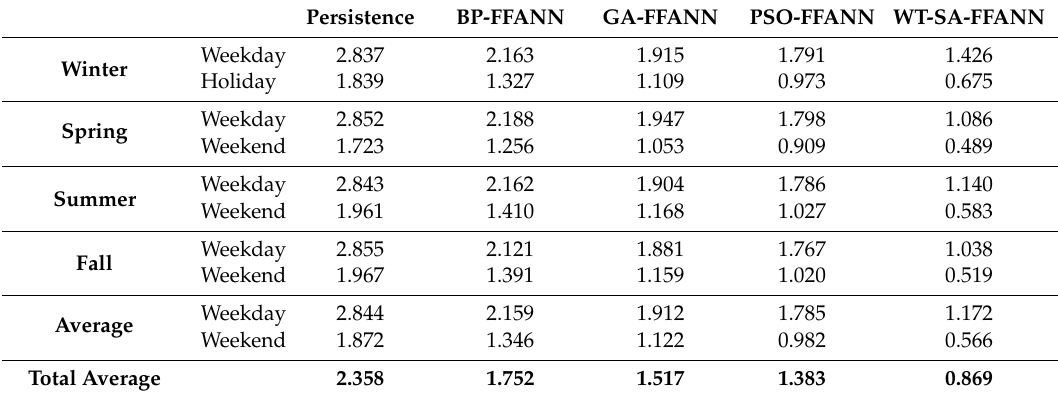
Table 5. Comparative NMAE